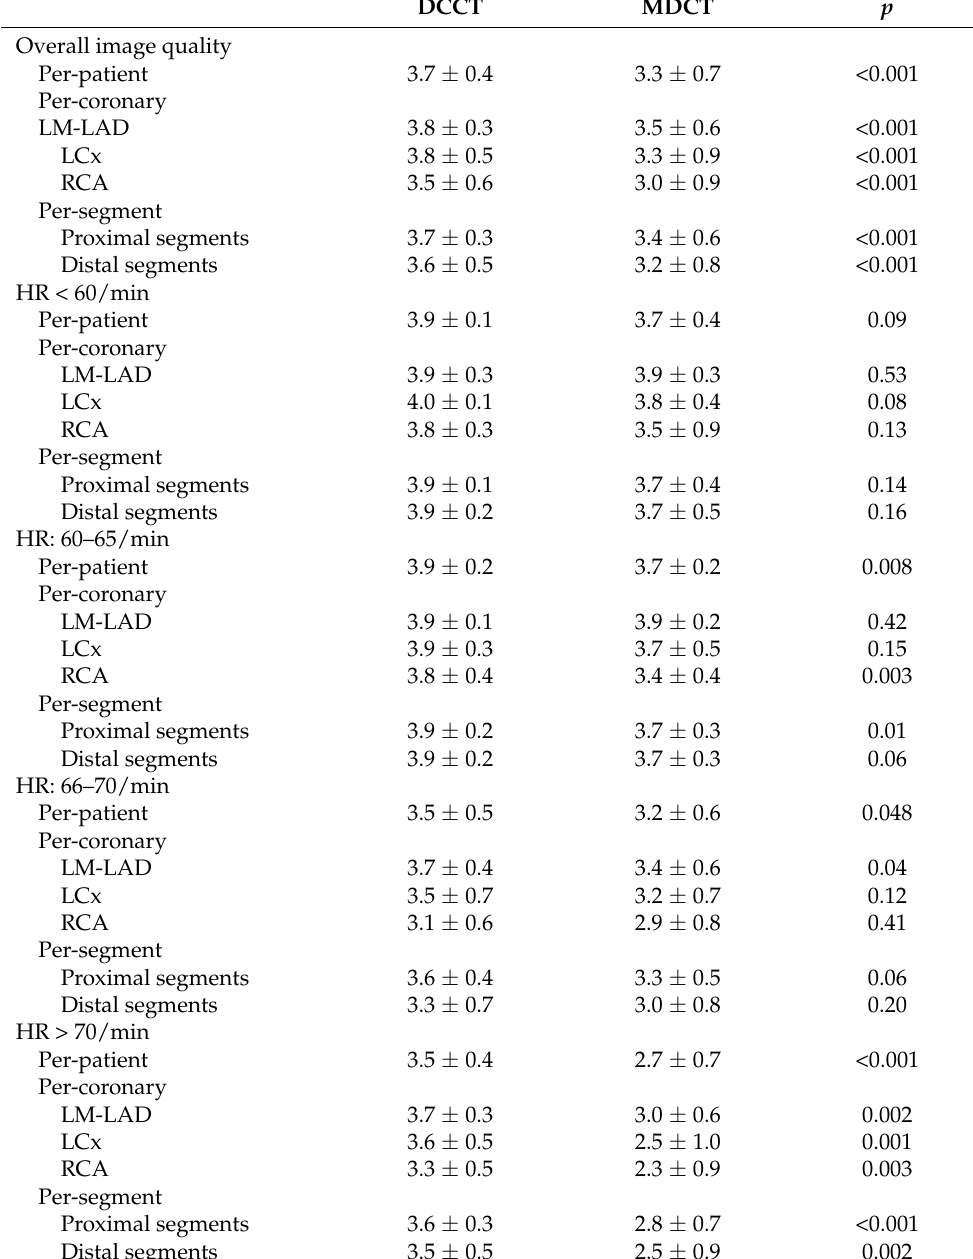
Table 3. Qualitative assessment of image